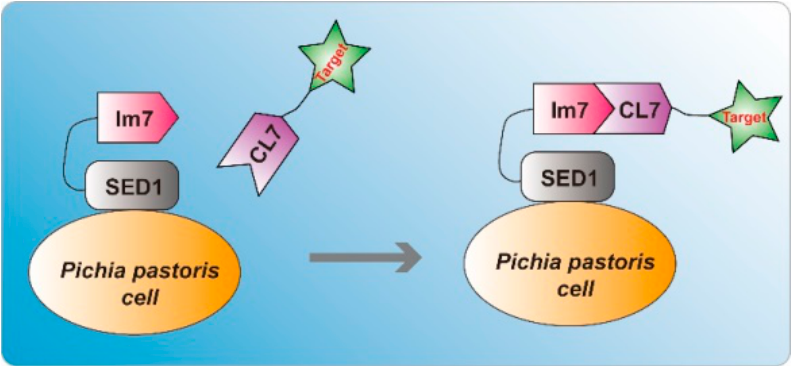
Figure 1. Schematic illustration of the indirect P. pastoris surface display system through the ultra ‐ high ‐ affinity interaction between Im7 and CL7. The Im7 ‐ SED1 fusion proteins are expressed and displayed on the surface of P. pastoris cells. The addition of CL7 tagged proteins leads to the indirect display of target proteins.